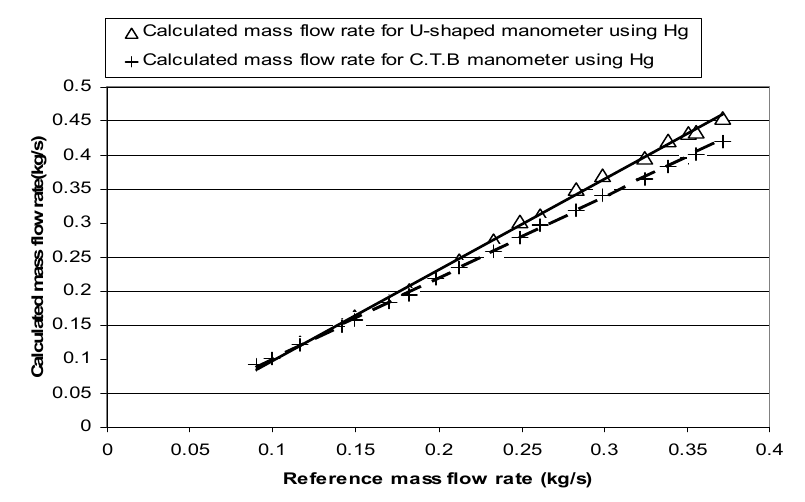
Figure 5. Comparison between reference and calculated mass flow rates in case of orifice meter using Hg as manometer